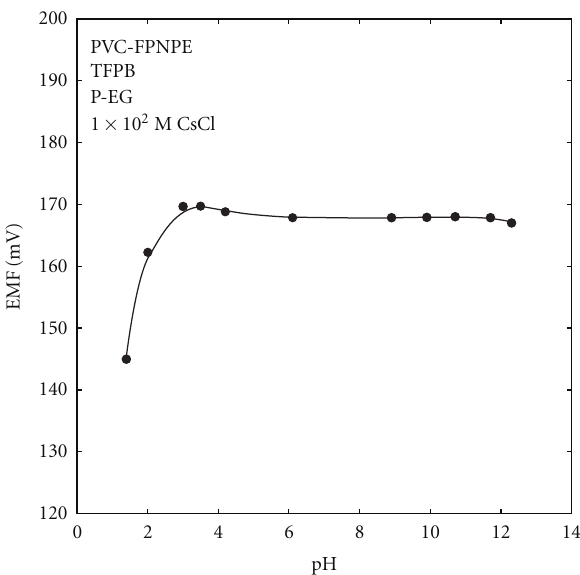
Figure 4: Mean potentiometric pH response of FPNPE-plasticized PVC ISEs containing P-EG and TFPB.